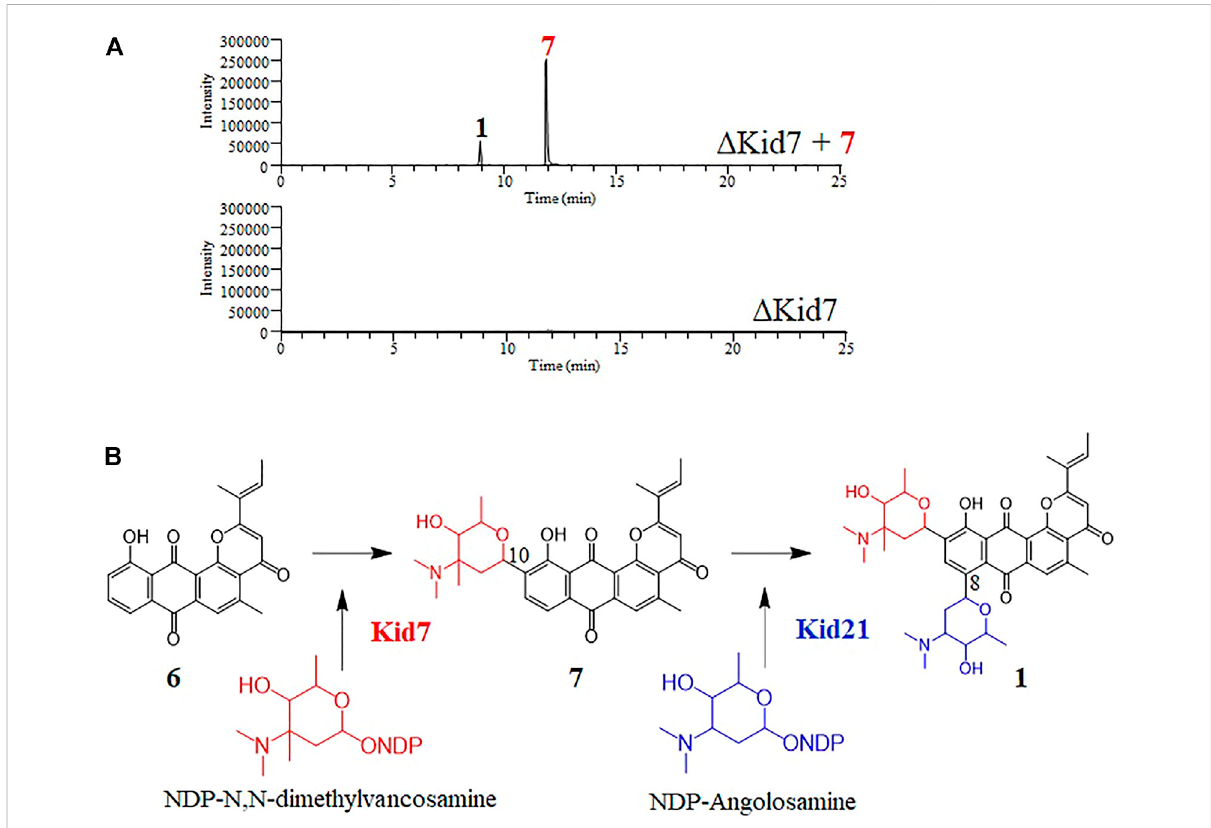
FIGURE 6 (A) Selected LC-MS analysis of the extracts of culture broth obtained from the bioconversion experiment of N,N-dimethylvancosamine glycosylated compound ( 7 ) by the Δ Kid7 mutant. The selected ion chromatograms were pre-set at m/z 532 and 689 correspond to the respective molecular ion of compound 7 and kidamycin ( 1 ), respectively. (B) The proposed glycosylation pathway of